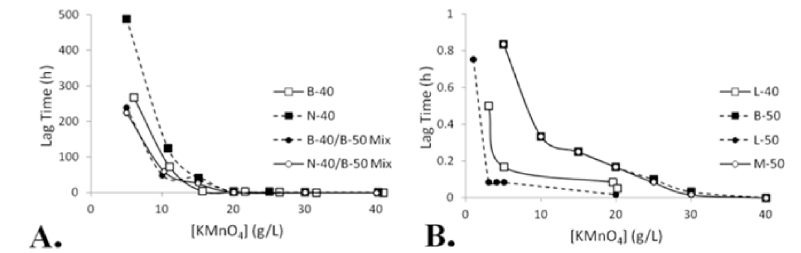
Figure 2. Gelation lag time as a function of KMnO 4 concentration in batch tests from ( A ) Bindzil 1440, Nalco 1142, Bindzil 1440/Bindzil 9950 mix, and Nalco 1142/Bindzil 9950 SRPGs and ( B ) Ludox TM-40, Bindzil 9950, Ludox TM-50, and Megasol S50